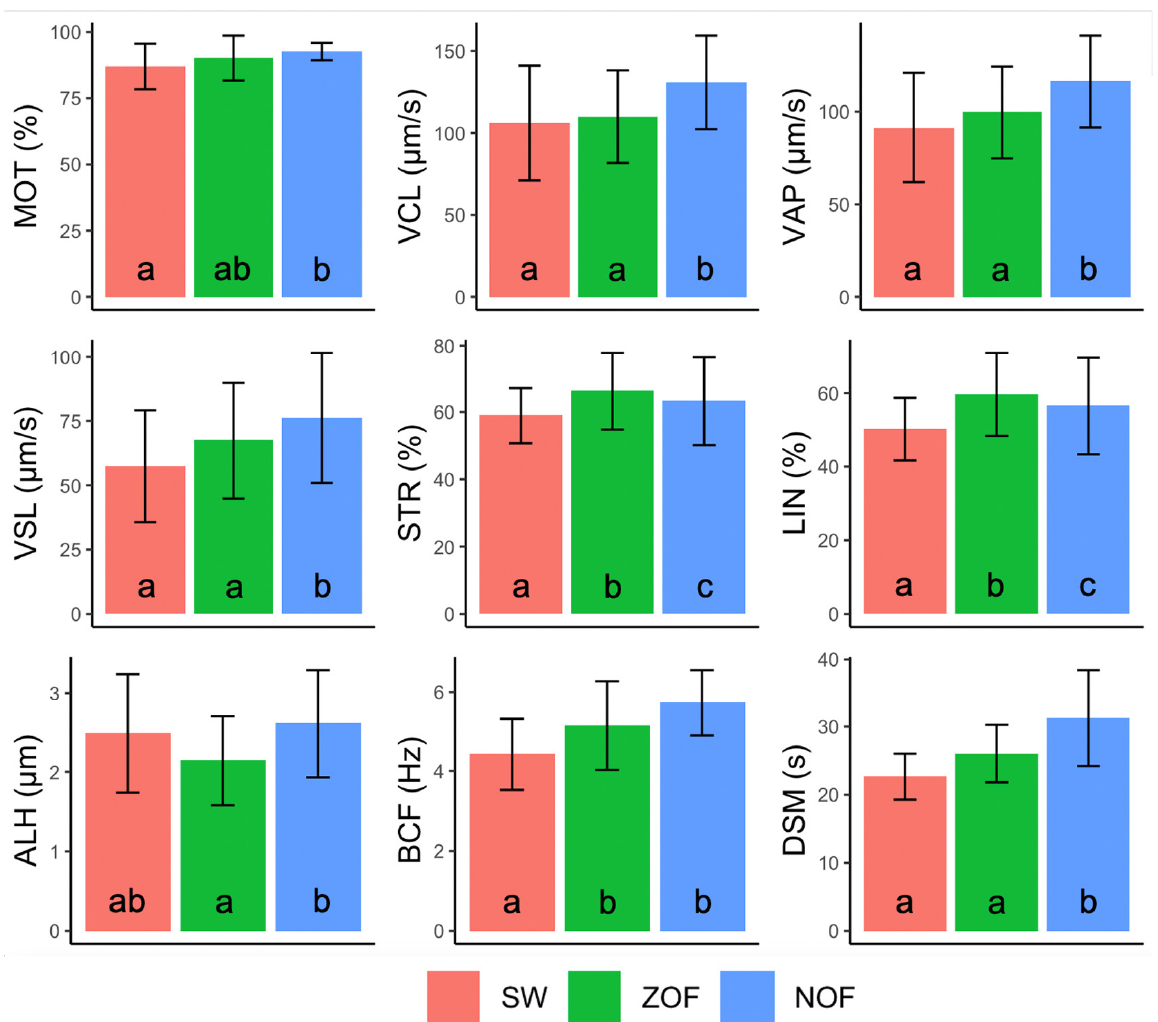
Figure 1. Barplots displaying the variability among treatments (spring water—SW; 20% native ovarian fluid—NOF; 20% zootechnical ovarian fluid—ZOF) for each sperm motility parameter, presented as Means ± SD (observations number in: SW= 10; NOF = 50; ZOF = 50). Error bars represent standard deviation. Different letters show significant differences among treatments.